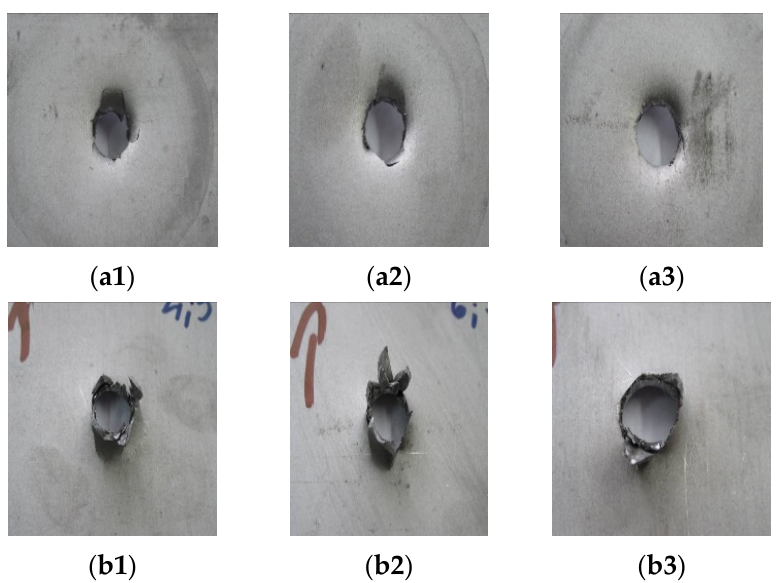
Figure 15. Results of dynamic impact tests of 1 mm Ti6Al4V sheet in layer structure of pairs: ( a1 – a3 ) view from above; ( b1 – b3 ) view from bottom.